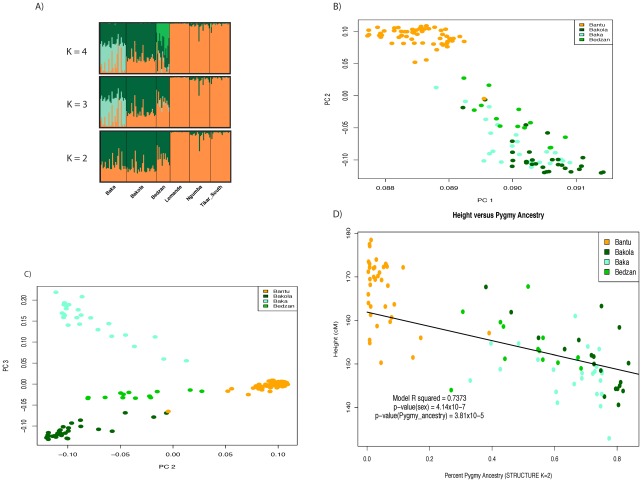
Admixture and population structure.Plots of principal components A) 1 versus 2 and B) 2 versus 3 calculated using 1M SNP data from 67 Pygmy and 58 Bantu samples. The proportion of variance explained by PCs 1, 2, and 3 is 0.245, 0.0192, and 0.0109, respectively. The three Pygmy ethnic groups are clearly distinguished from their neighboring Bantu populations by the first two PCs, while the third differentiates the three Pygmy groups from one another. C) Regression of height on Pygmy ancestry inferred using STRUCTURE (K = 2). Higher levels of Pygmy ancestry are associated with shorter stature. The trend line intersects the intercept from the full model and has a slope equal to the regression coefficient for percent ancestry. D) Visualization of percent ancestry inferred using STRUCTURE at K = 2, 3, and 4.